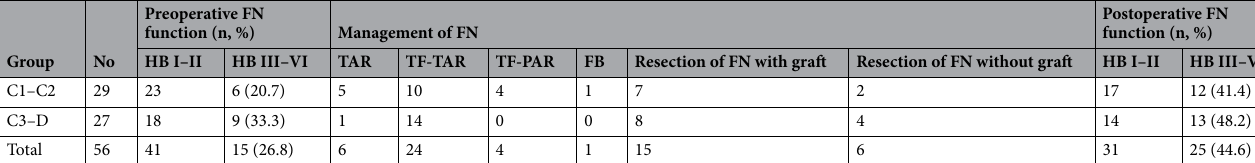
Table 2. Preoperative, postoperative FN function and intraoperative management of FN (n = 56). FN facial nerve, TAR total anterior rerouting, TF-TAR total anterior rerouting with tension-free FN rerouting technique, TF-PAR partial anterior rerouting with tension-free FN rerouting technique, FB fallopian bridge of facial nerve.